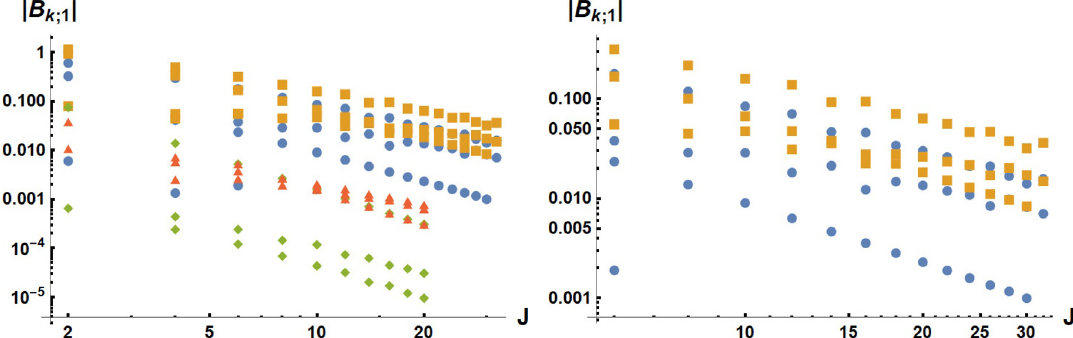
Figure 5 . We plot the absolute value of the functional contribution for various operators as a function of spin. The green and red plots correspond to the B applied to the h σσσσ i correlator. The blue and orange plots correspond to the B functionals applied to the h (cid:15)(cid:15)(cid:15)(cid:15) i correlator respectively. The right panel is a close-up of B (2 , 0 , 0 , 0);1 the B functionals applied to the h (cid:15)(cid:15)(cid:15)(cid:15) i correlator. In the right panel, one double-twist k ;1